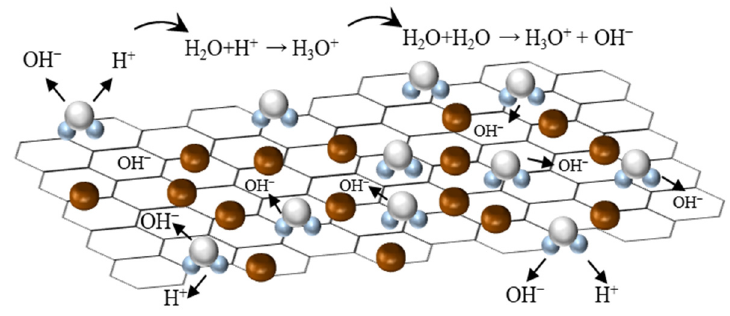
Figure 9. Humidity sensing mechanism diagram of the SnO 2 /rGO